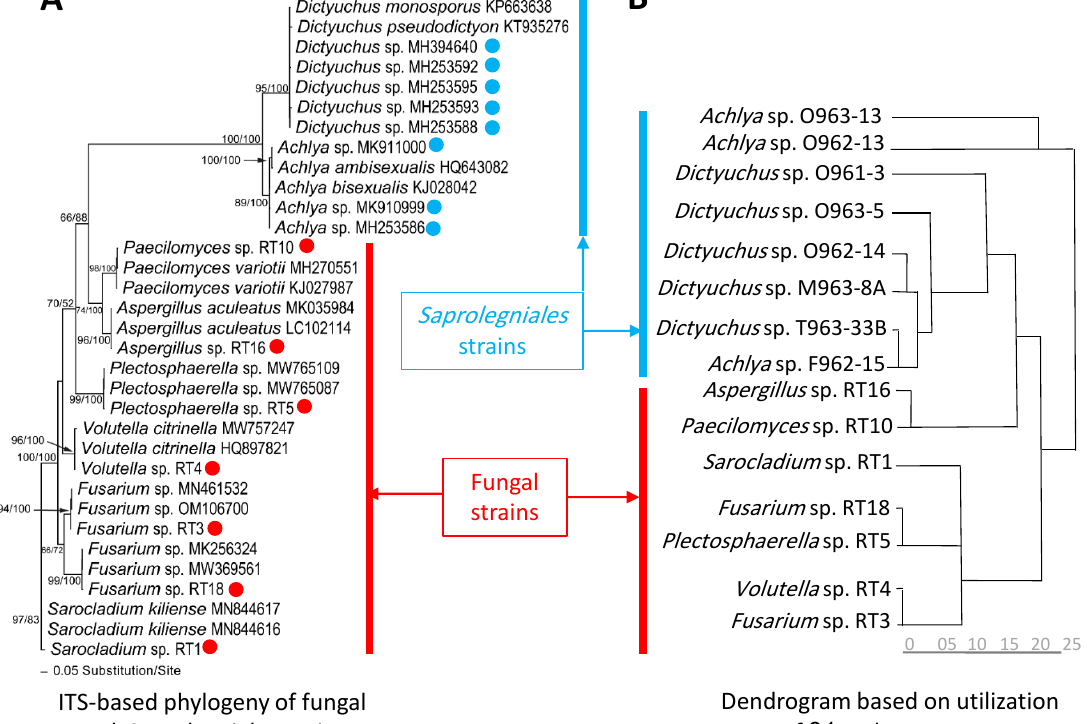
Figure 2. Phylogram of the best ML trees (lnL = − 4501.7999) revealed using RAxML from an analysis of ITS ( A ) and the dendrogram ( B ) based on utilization of 31 carbon sources of seven fungal and eight oomycete strains and related taxa. The analyses for constructing the dendrogram were performed based on the last five measurements (average from the replicates). Blue and red circles represent Saprolegniales and fungal strains isolated in this study. ML and MP bootstrap supports above 50% were given at the first and second positions, respectively, above or below the